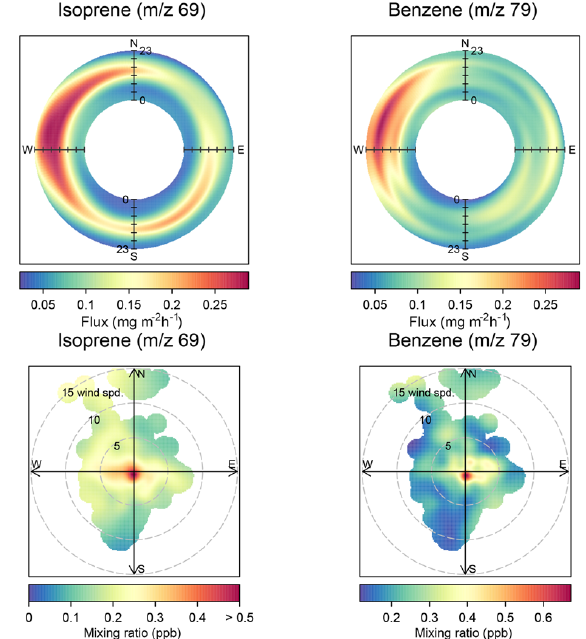
Figure 9. Polar annulus and polar plots for isoprene ( m/z 69) and benzene ( m/z 79) fluxes (top) and mixing ratios (bottom) (colour scale) by time of day (top), wind speed (bottom) and wind